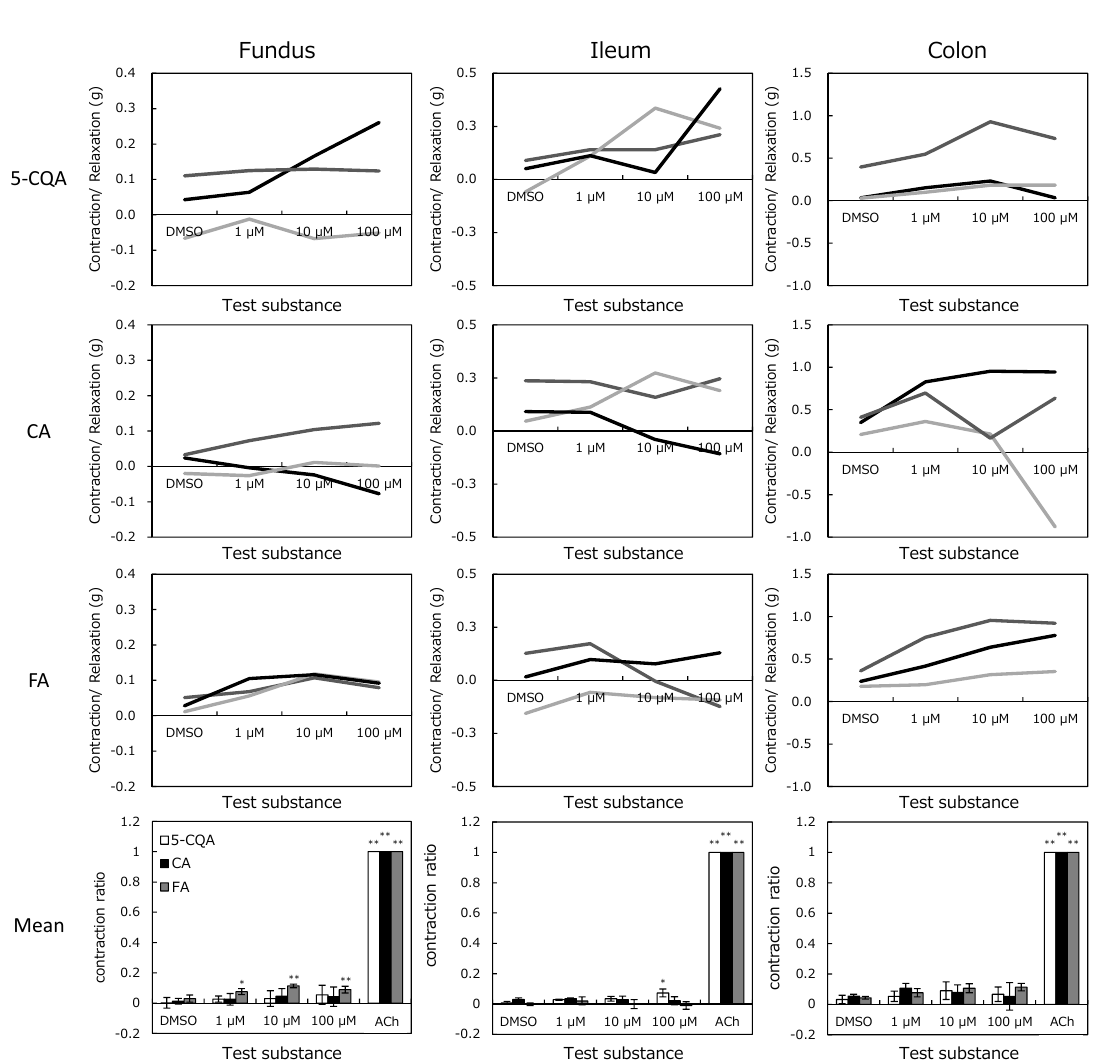
Figure 6. Concentration-response curves of chlorogenic acids from the fundus, ileum, and colon isolated from guinea pig. Test substances were applied to organs after a stabilization period. Values represent the exchange of isolated organ tension compared to before dimethyl sulfoxide (DMSO) application. Mean represents mean ± SEM of the contraction normalized to 20 µM acetylcholine (ACh) in the fundus and 0.2 µM ACh in the ileum and colon. * p < 0.05 and ** p < 0.01 to DMSO by Dunnett’s test.